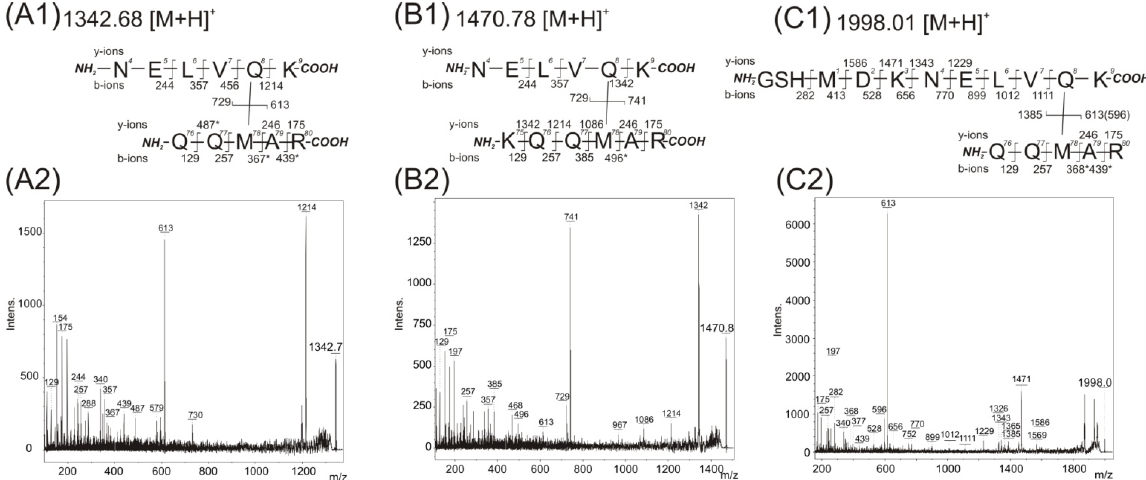
Figure 3. Acquired mass spectrometry (MS)/MS spectra after trypsin digestion of 14-3-3 homodimer band and detected fragment ions corresponding to covalently photo cross-linked structures. The structures of covalently cross-linked Gln8–Met78 ( A1 ), ( B1 ), and ( C1 ) determined from MS/MS daughter ion spectra with detected peaks at m / z 1342.75 ( A2 ), m / z 1470.84 ( B2 ), and m / z 1998.01 ( C2 ), respectively. The residue numbering corresponds with the full-length sequence of the 14-3-3 ζ (UniProtKB database accession number P63104). Intens. means absolute intensity; asterisks marks the secondary fragmentation after inter-peptide cross-linked bond